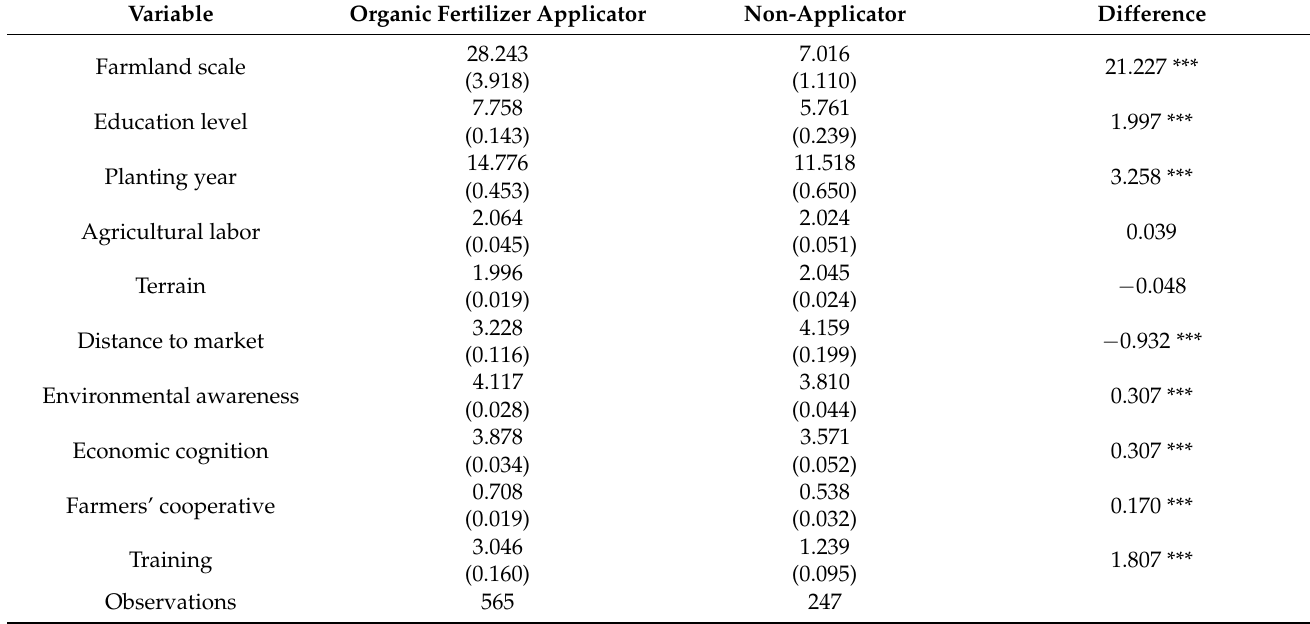
Table 2. Mean difference of the variables used in the sample selection